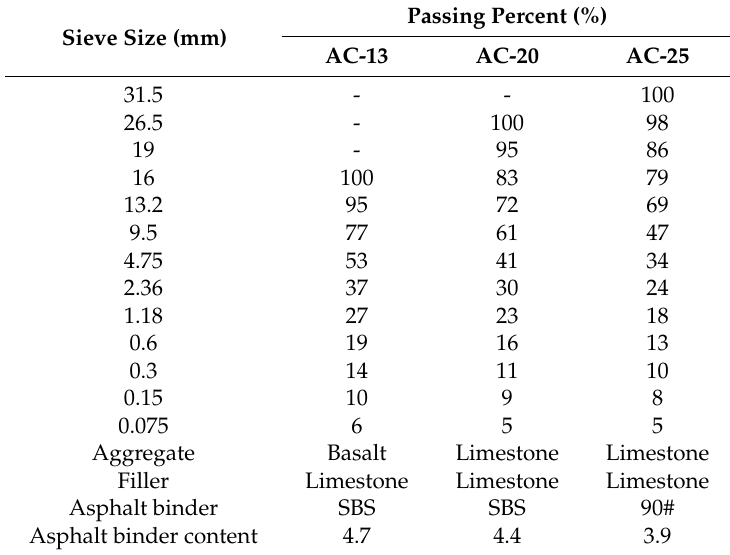
Table 3. Compositions of asphalt mastic contained filler and asphalt binder.